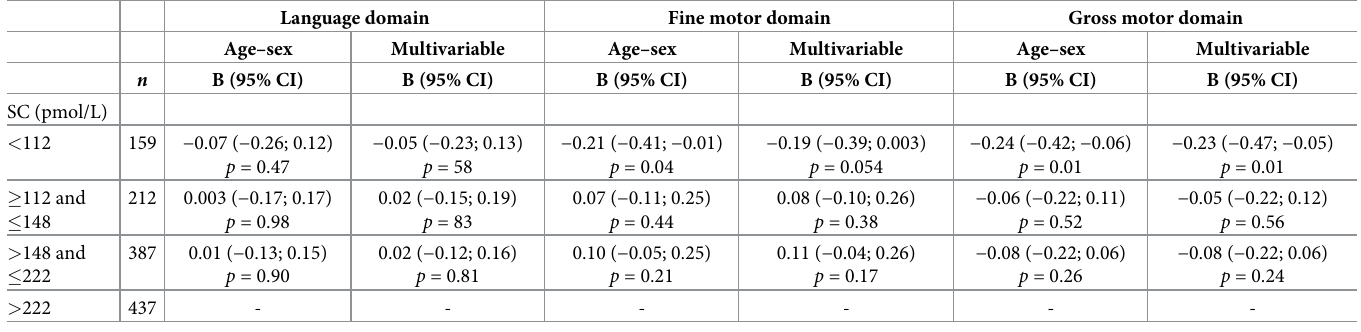
Table 5. SC as correlate of MDAT z-scores in 1,192 children with MAM 1 .